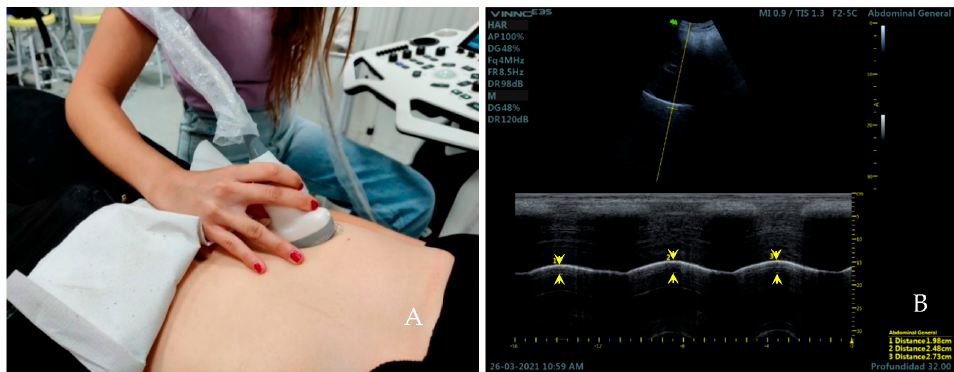
Figure 2. Placement of the transducer over the anterior subcostal region for the measurement of diaphragmatic excursion ( A ). Ultrasound image obtained over this area ( B ). Distance 1, 2, and 3 (yellow arrows) correspond to the excursion of the diaphragm during the first, second, and third respiratory cycle at current volume; respectively.